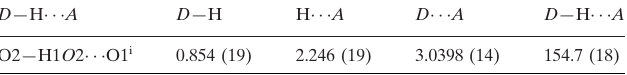
Hydrogen-bond geometry (A˚ , (cid:5)